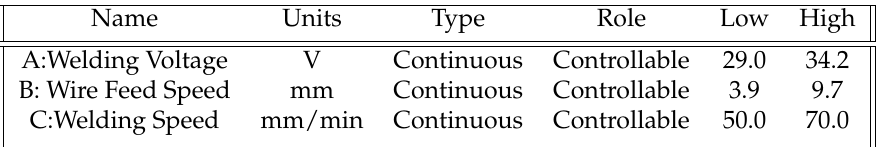
Table 1. Defining of controllable factors to be measured